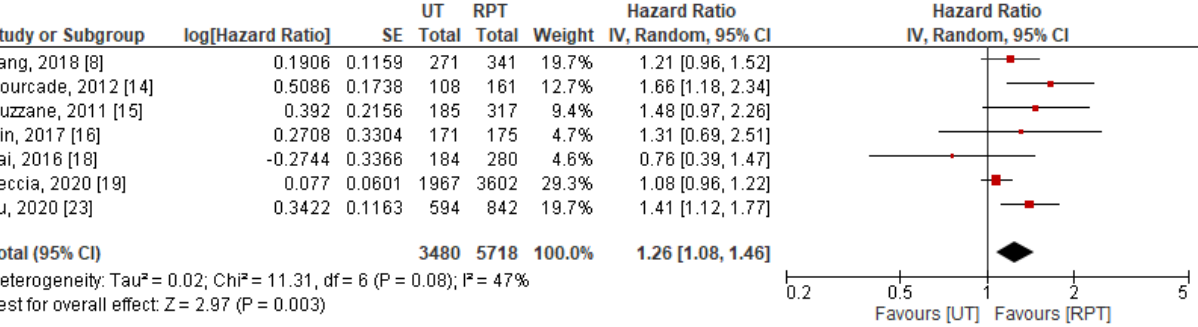
Figure 4. Forest plot and meta-analysis of overall survival [8,14–16,18,19,23]. CI = confidence interval; IV = inverse variance; RPT = renal pelvic tumor; SE = standard error; UT = ureteral tumor.